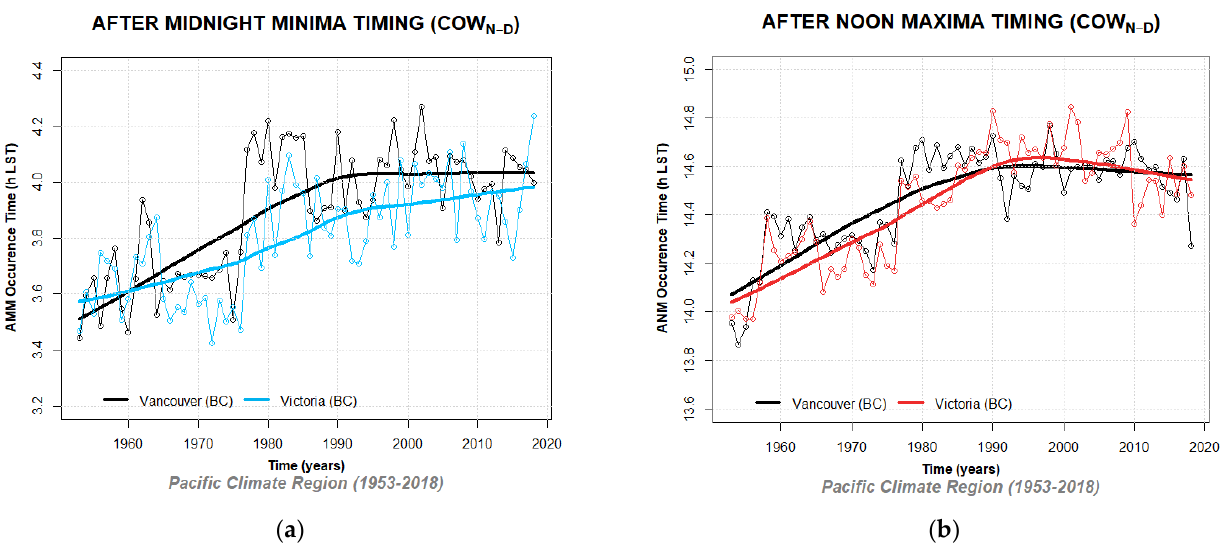
Figure A23. Annually averaged After Midnight Minima ( a ) and After Noon Maxima timing shifts ( b ) and LOESS fit curves for Vancouver (BC) and Victoria (BC) temperature time series, Pacific Coast climate region.